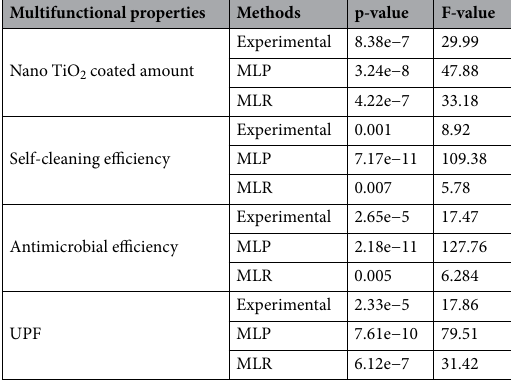
Table 5. Analysis report of the experimental values and the predicted values using MLP and MLR for functional properties of nano TiO 2 coated